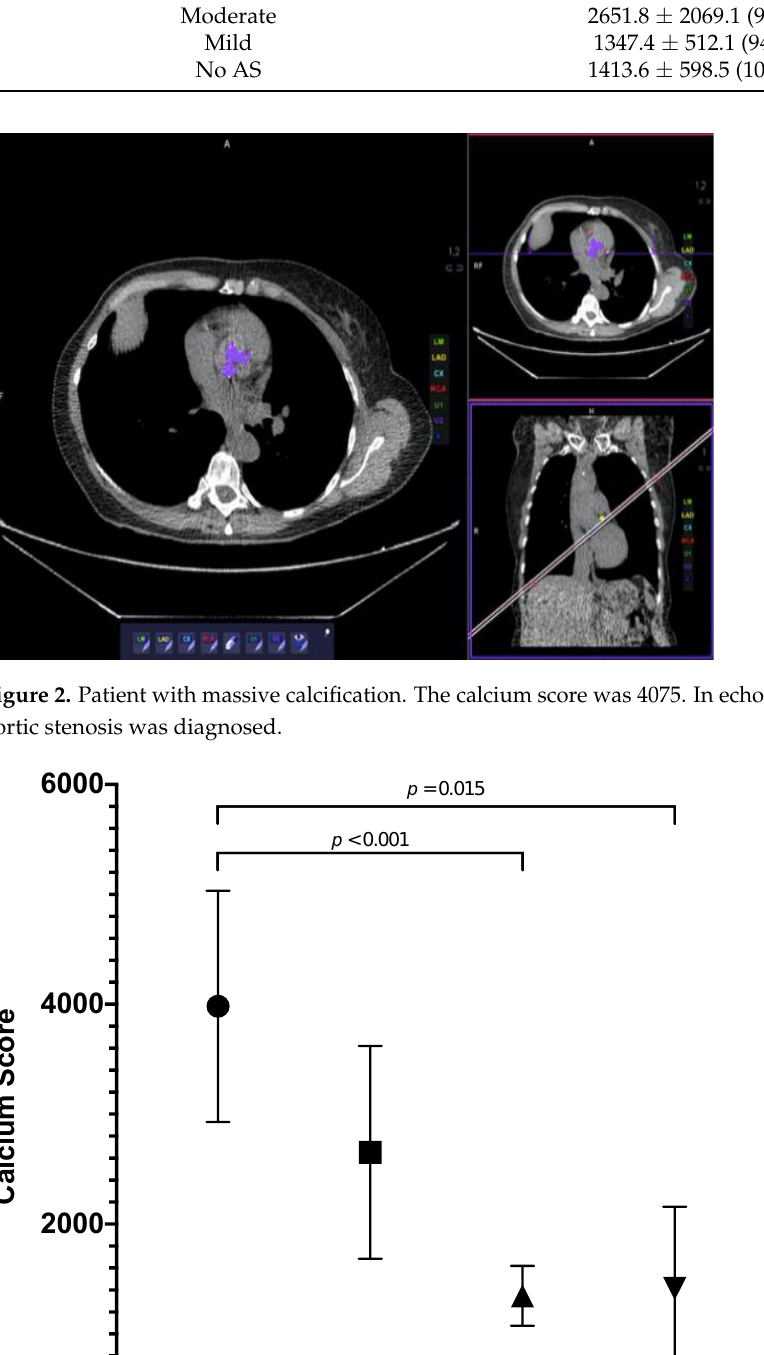
Table 2. The results of CS. CS — calcium score, AS — aortic stenosis.